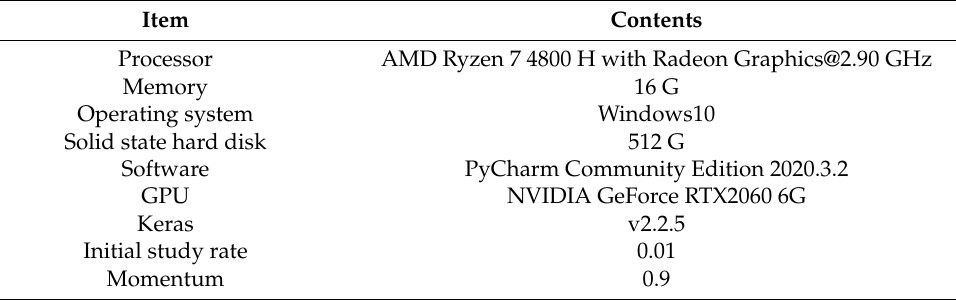
Table 3. Experimental environment and parameter setting.